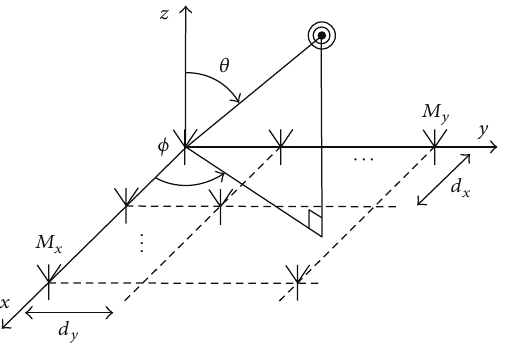
Figure 1: The uniform rectangular